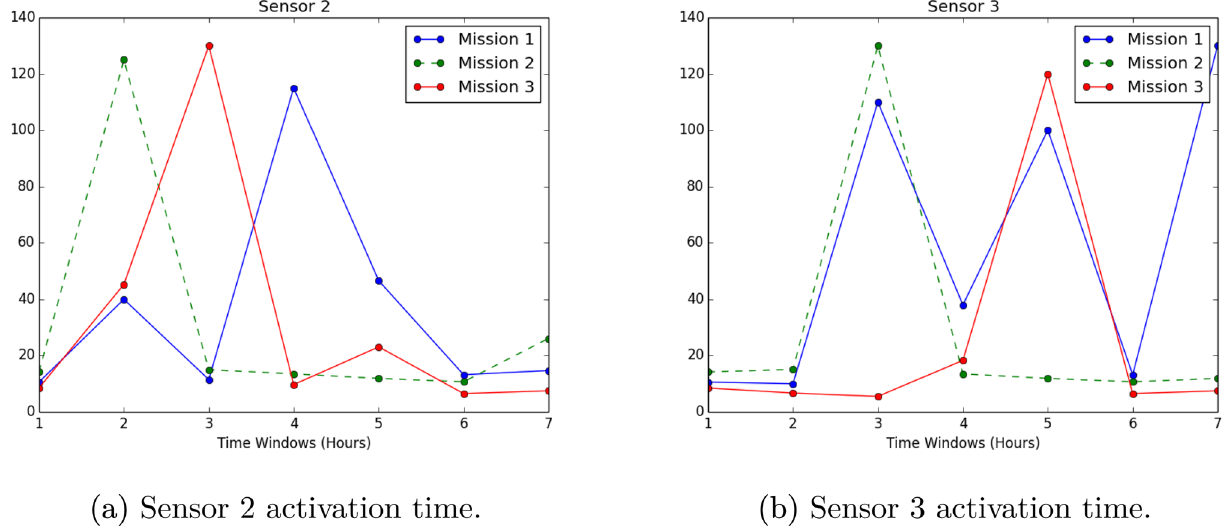
Fig. 6 Scheduling the activation of sensors 1, 2 for each mission